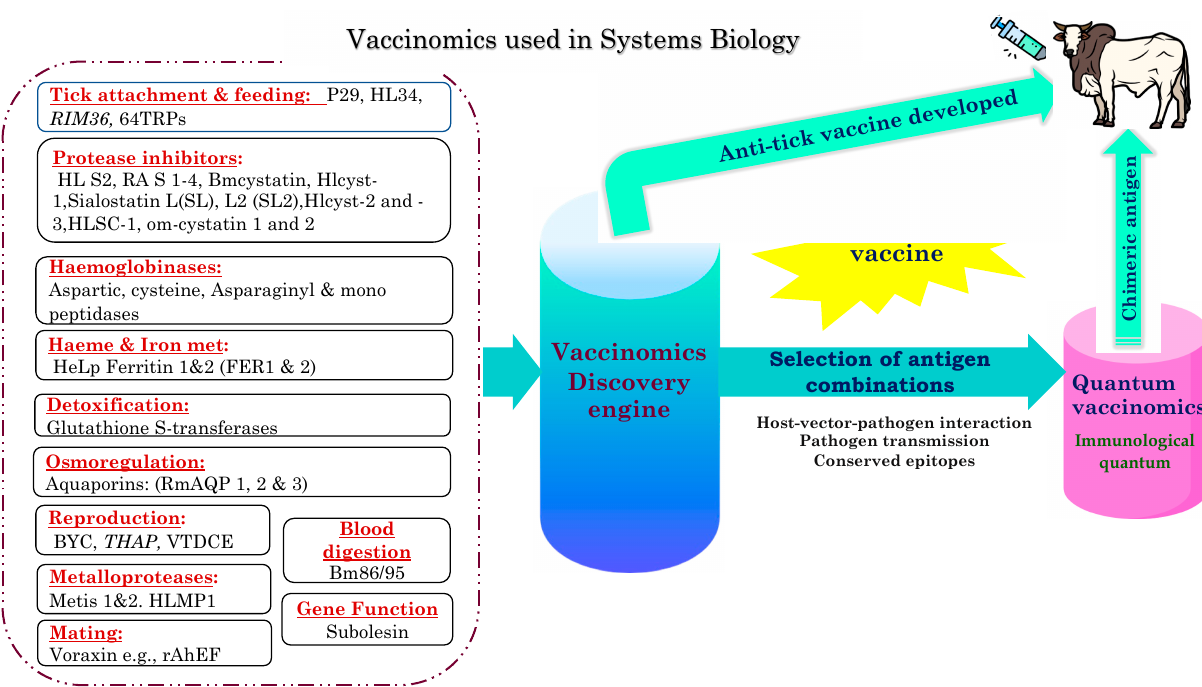
Figure 2. Using vaccinomics in a systems biology approach to identify and characterize protective antigens or select suitable antigen combinations for identification of non-redundant epitopes (immunological quantum) for designing multi-epitope based (chimeric) antigens.